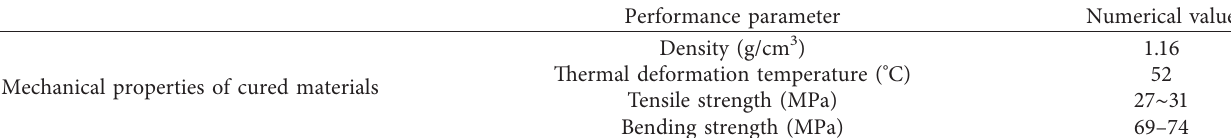
Table 6: Performance parameters of 3D printing materials.